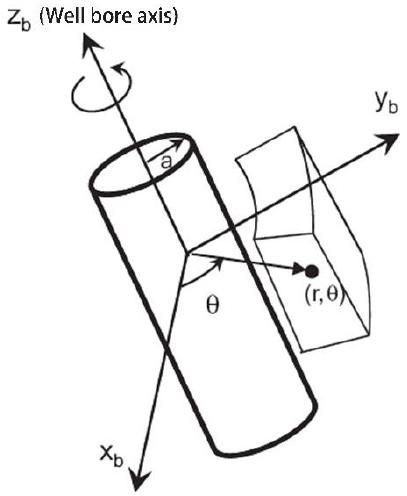
Figure 9. The conversion relationship between well bore right angle coordinate system and well bore column coordinate system.